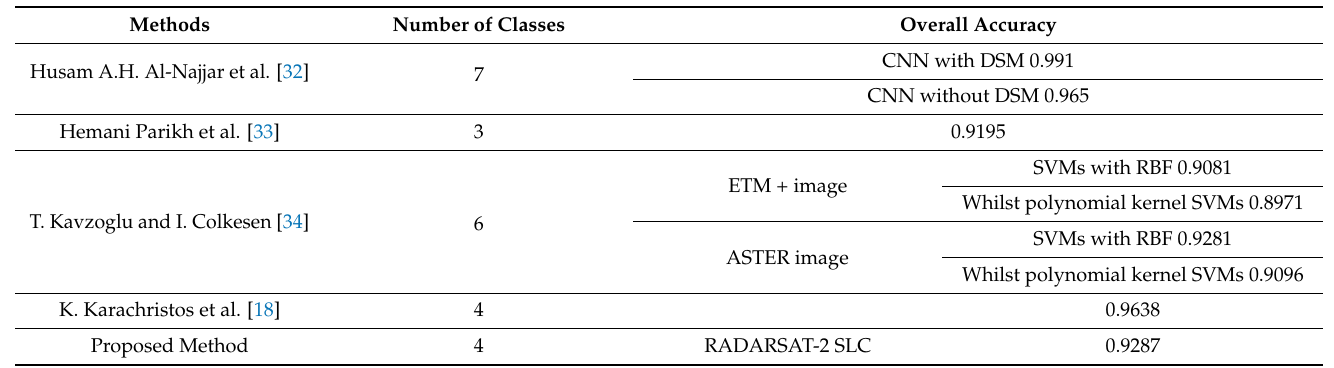
Table 4. Classification accuracies for different approaches in land cover